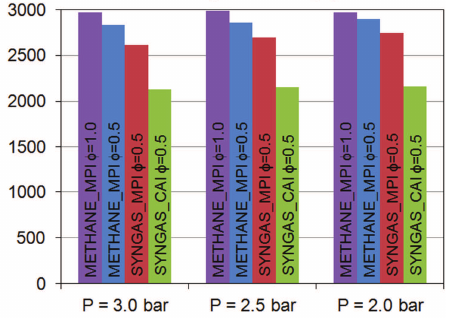
Fig. 20. Maximum temperatures in the combustion chamber The last presented result is NO emission. For methane x combustion very similar NO emission was obtained for x equivalence ratio ϕ = 1.0 and ϕ = 0.5. Although maximum temperatures in the combustion chamber and NO mass x were reduced with lower equivalence ratio, the power